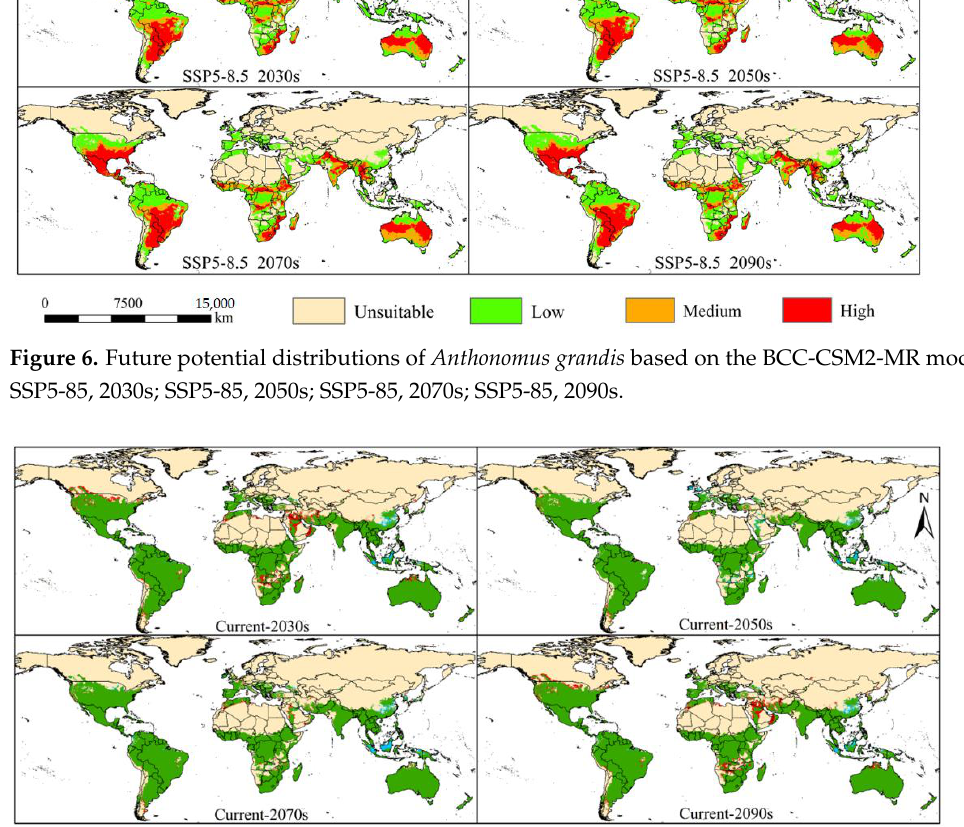
Figure 7. Future changes in potential suitable global habitats areas of Anthonomus grandis in different periods vs. the current climate scenario.